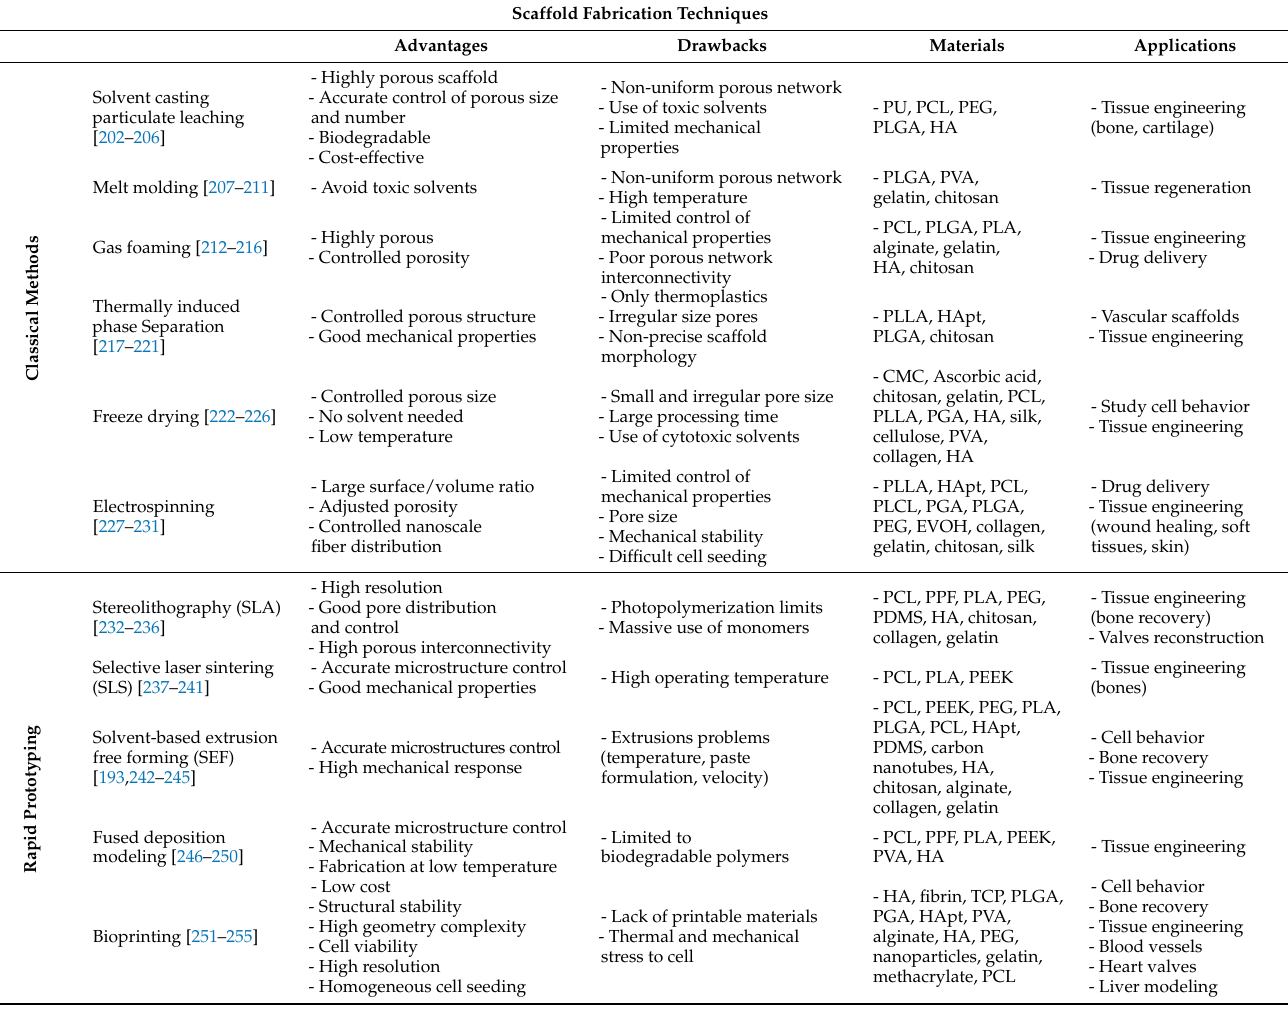
Table 1. Representative overview of scaffold fabrication techniques, materials and applications [179,193–201]. Scaffold Fabrication